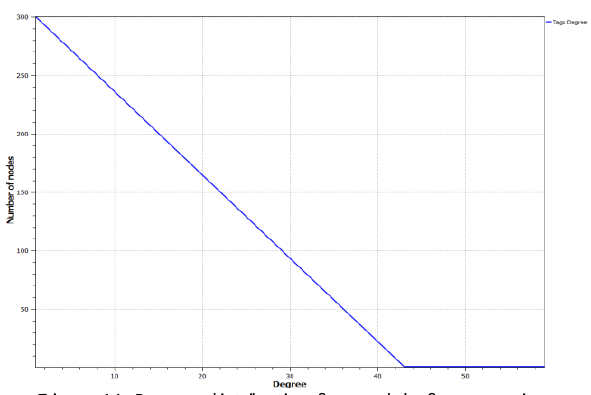
Figure 11. Degree distribution for graph before grouping.